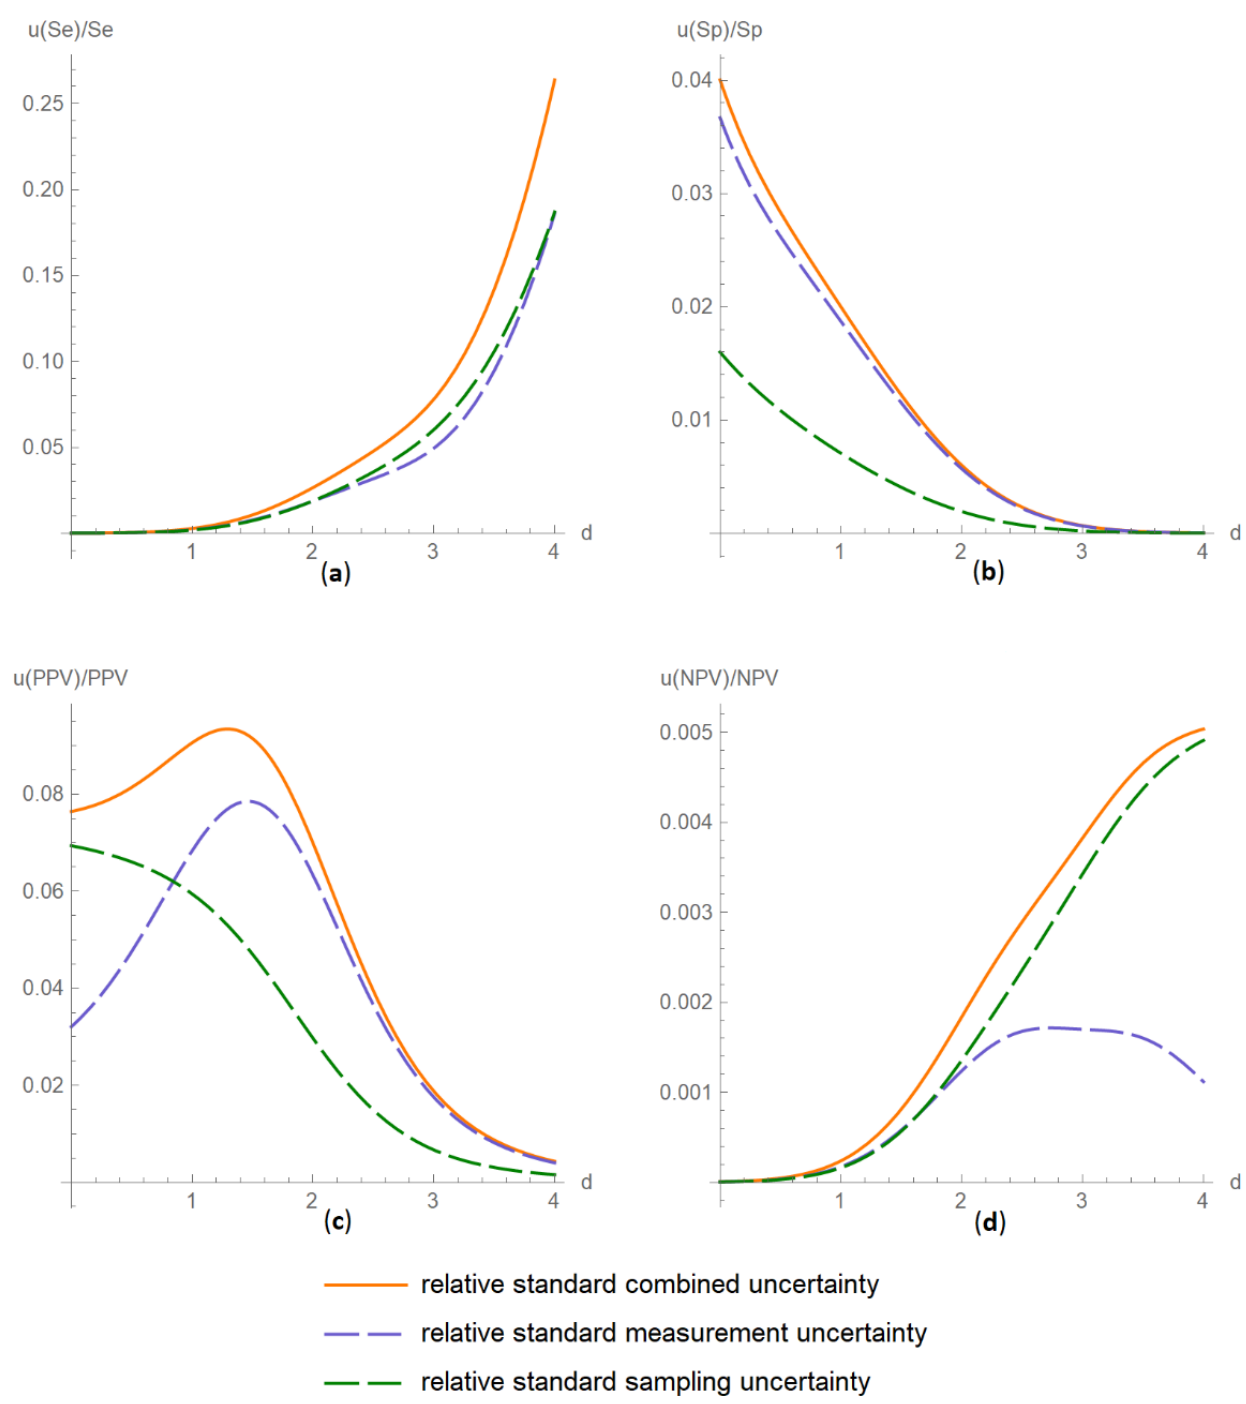
Figure 16. DAM standard uncertainties versus diagnostic threshold plots. Plots of standard combined, measurement and sampling uncertainties of ( a ) sensitivity ( u ( Se )), ( b ) specificity ( u ( Sp )), ( c ) positive predictive value ( u ( PPV )) and ( d ) negative predictive value ( u ( NPV )) versus diagnostic threshold ( d ) curves, with the respective parameter settings in Table 4.